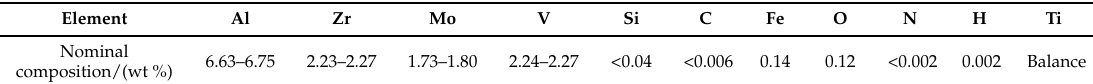
Table 1. Chemical composition of TA15